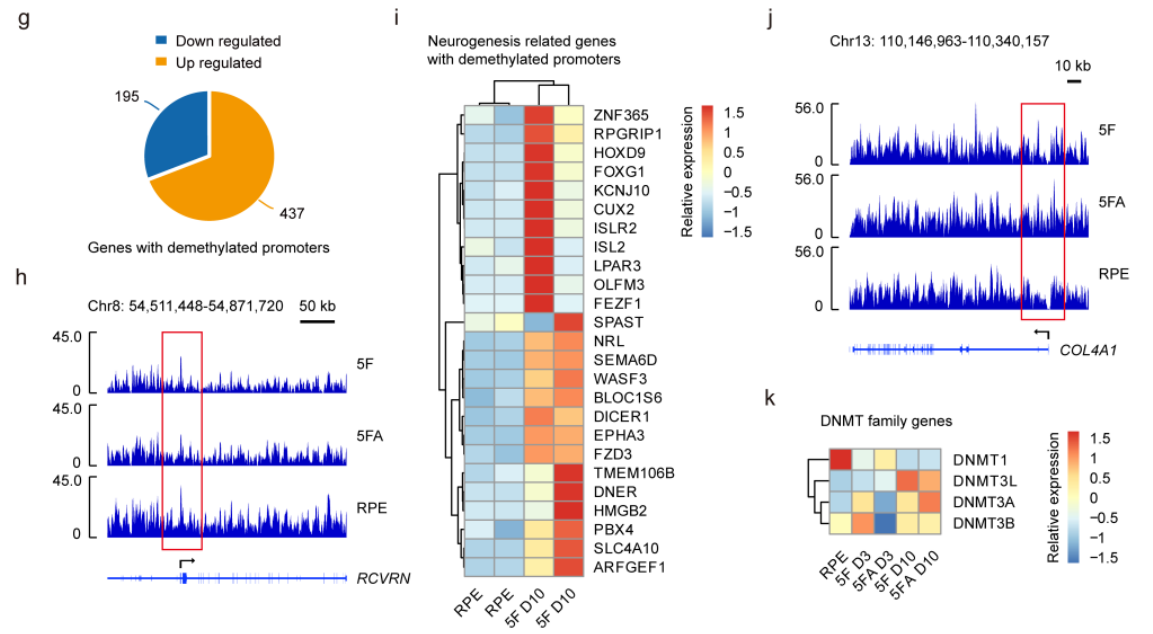
Figure 4. Global DNA methylation remodeling during direct reprogramming of RPE cells to R-CiPCs. ( a ) Line plot showing the average methylation level across the gene body. TSS, transcription start site. TES, transcription end site. ( b ) Heatmap showing gene expression changes of the TET family genes. ( c ) Pie plot showing the distribution of methylation changes at gene promoters upon 5F treatment. ( d ) GO analysis on the genes close to the dramatically demethylated regions due to CiPCs conversion. ( e ) Heatmap showing the level of methylation at the promoters of genes involved in photoreceptors maintenance. ( f ) Heatmap showing the level of methylation at the promoters of genes involved in epithelium development. ( g ) Pie plot showing the proportion of down- and upregulated DEGs that harbored hypomethylated promoters upon 5F treatment. ( h ) Example of genome browser view of DNA methylation profiles of RCVRN in R-CiPCs and RPE cells. ( i ) Heatmap showing the neurogenesis-related genes that were upregulated with hypomethylated promoters upon 5F treatment. ( j ) Example of genome browser view of DNA methylation profiles of COL4A1 in R-CiPCs and RPE cells. Each track shows the percent methylation of individual CpGs. ( k ) Heatmap showing gene expression of the DNMT family genes during direct reprogramming.